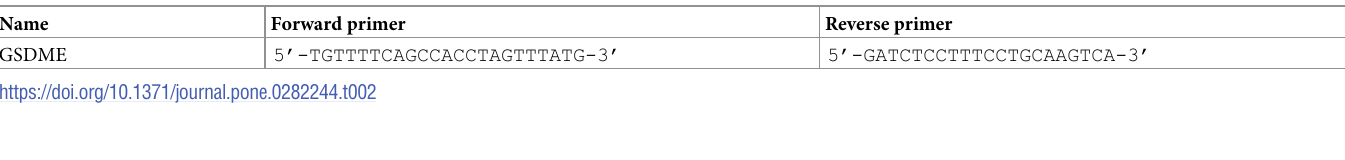
Table 2. Polymerase chain reaction (PCR)